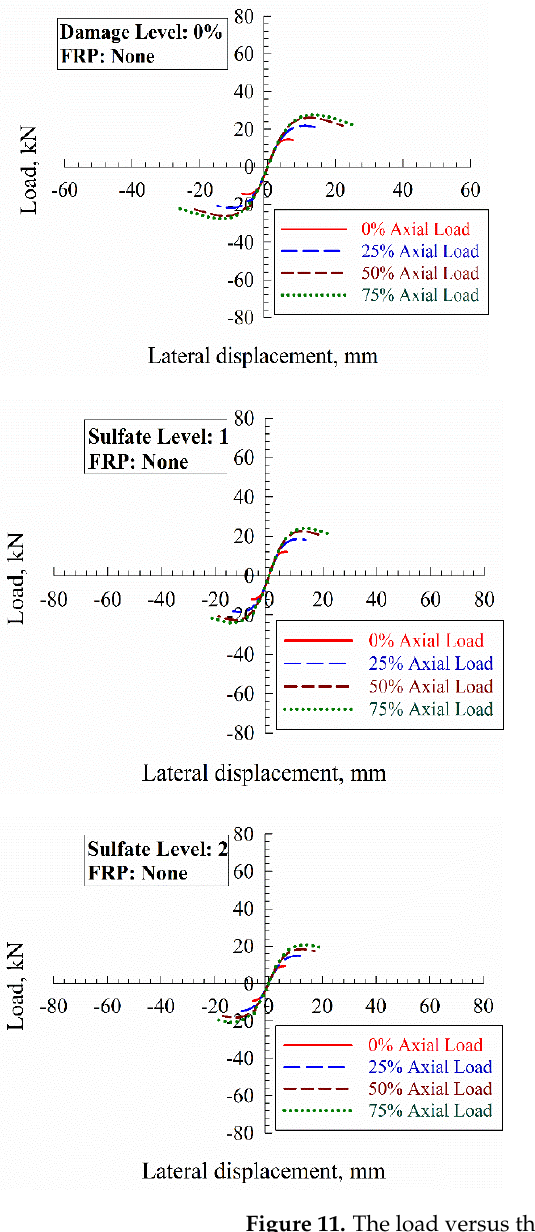
Figure 10. Hysteretic loops for 50% damaged joints.